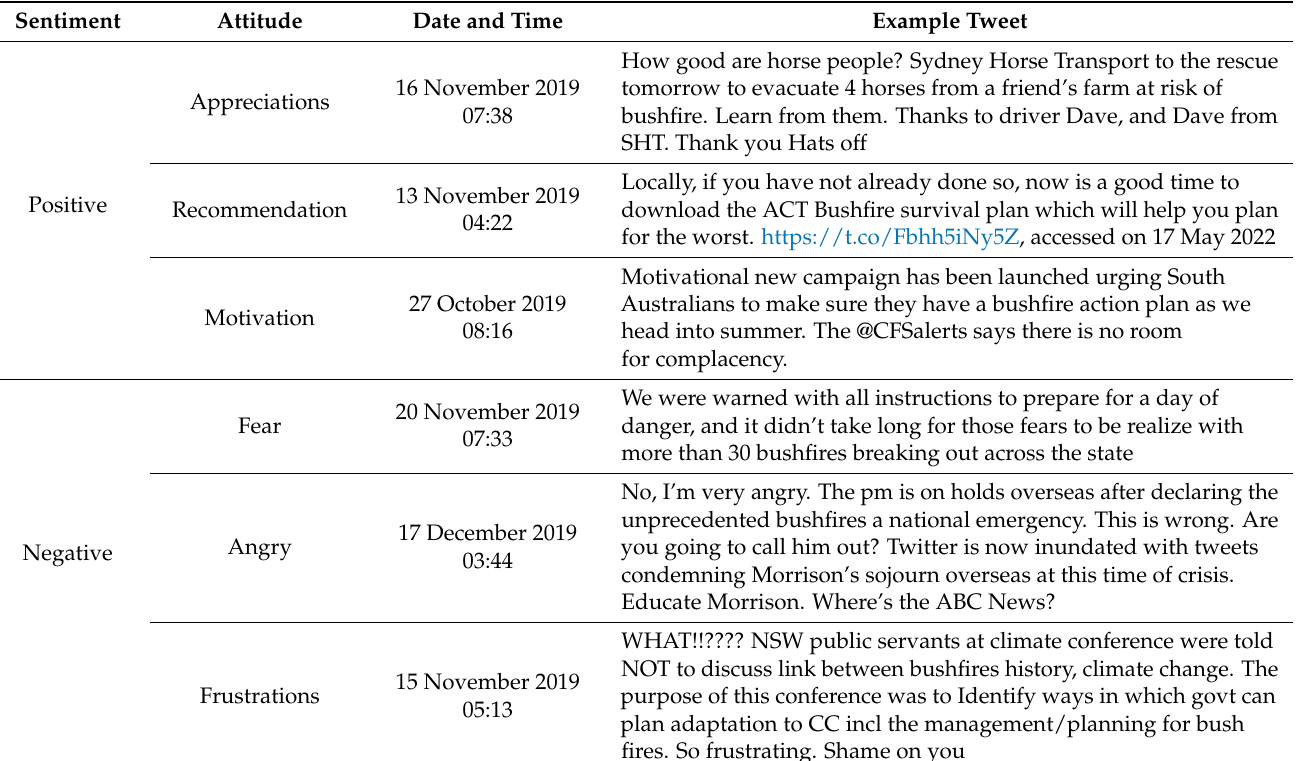
Table 4. Example tweets by sentiments and attitudes.